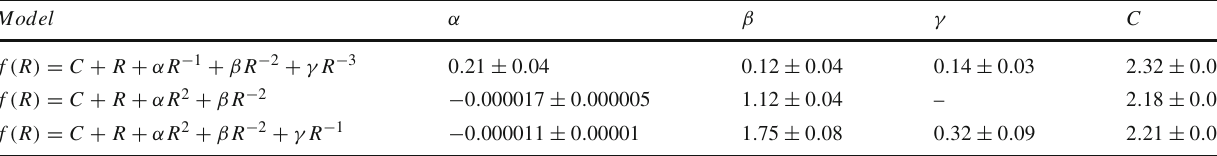
Table 2 Form of the f ( R ) theory and constraints obtained for the model parameters when H 0 = 73 . 52 ± 1 . 62 km s − 1 Mpc − 1 has been merged to the expansion rate data used in the GP. The constraints are for the three models given in Eqs. (18), (20) and (21), respectively Model